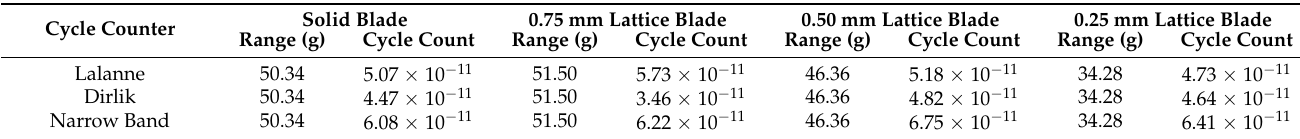
Table 6. PSD cycle count for each blade measured response.